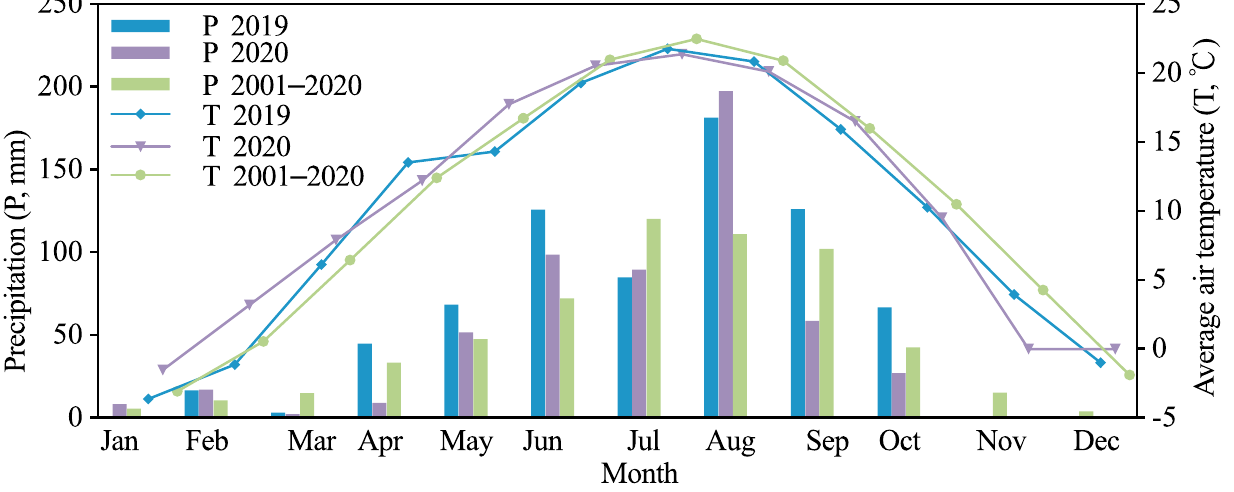
Figure 1. Distribution of monthly precipitation and average air temperature in 2019, 2020, and the long terms (2001 − 2020) in the study area.